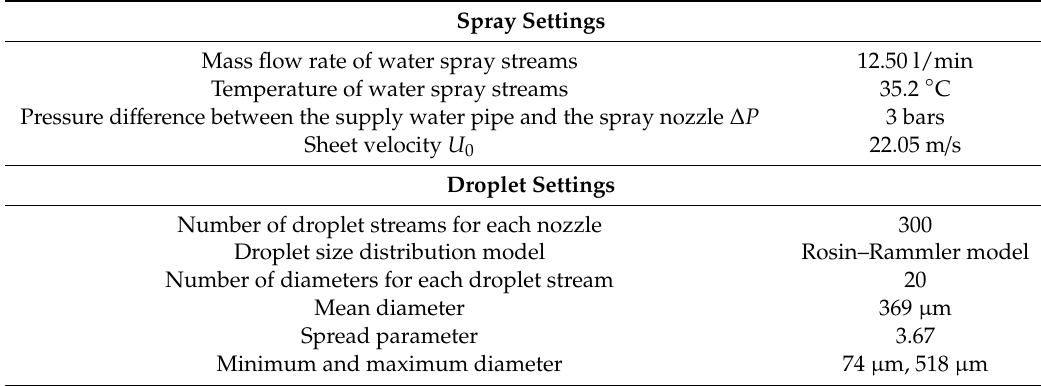
Table 2. Spray and droplet characteristics